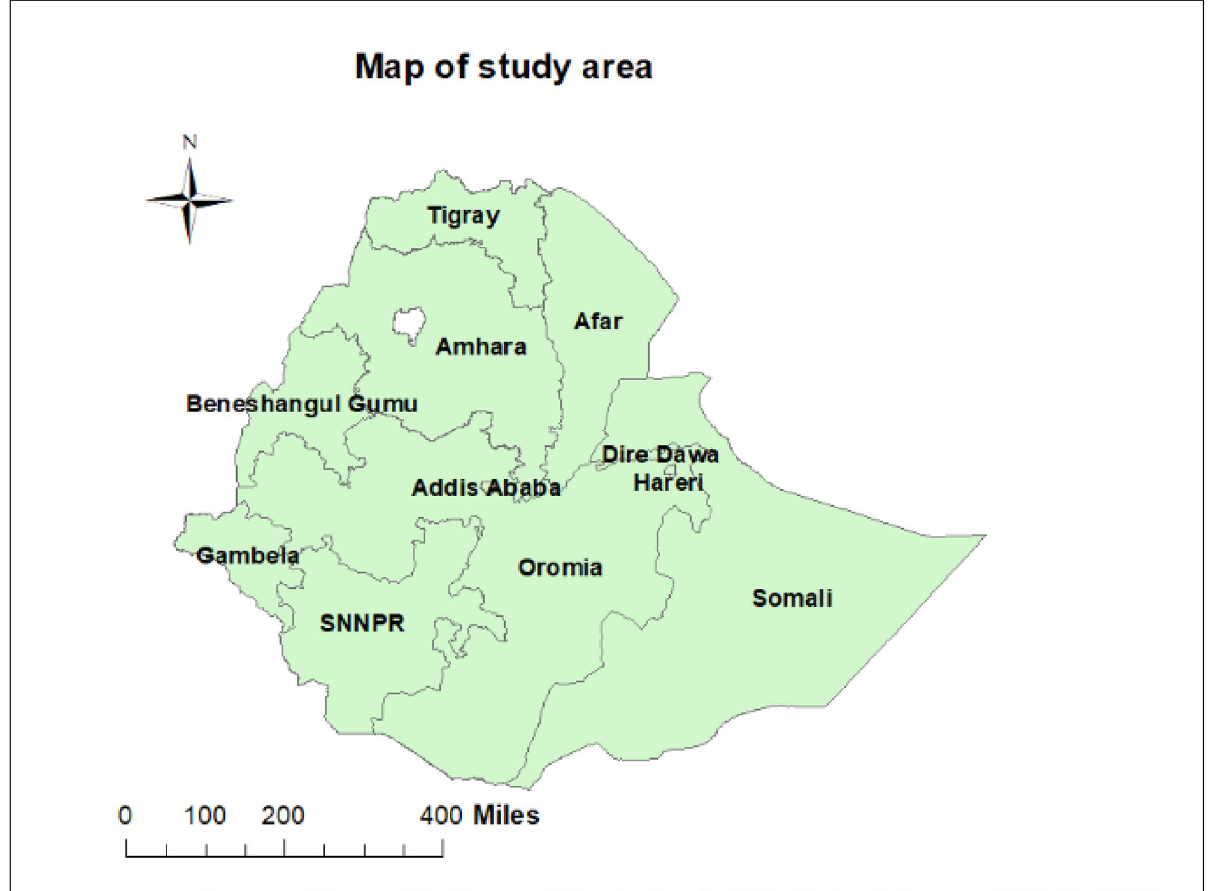
Fig 1. Map of study area,